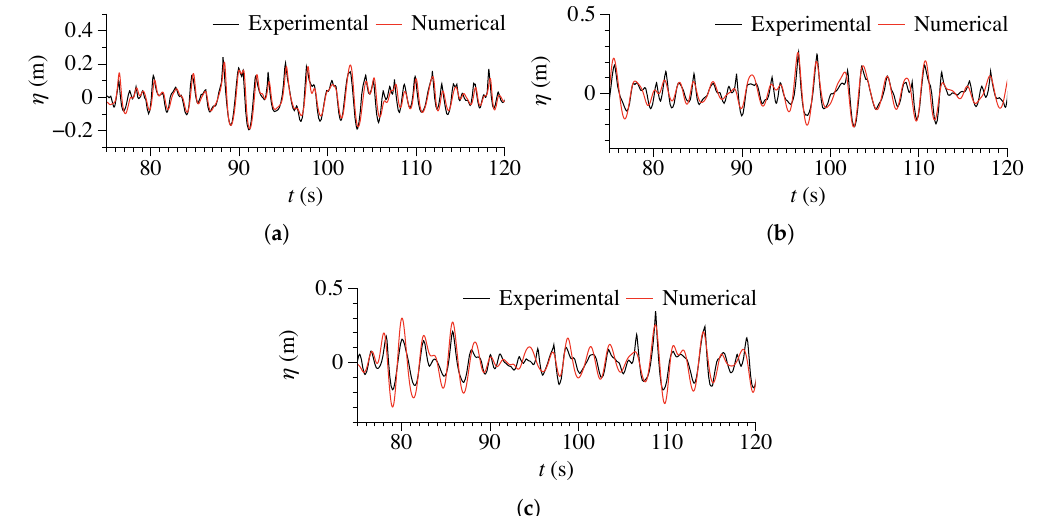
Figure 11. Comparison of the numerically reconstructed and experimental irregular wave signal for steep irregular waves in deep water at ( a ) W1 ( x = 1.4 m); ( b ) W2 ( x = 15 m); ( c ) W3 ( x = 34.74 m).